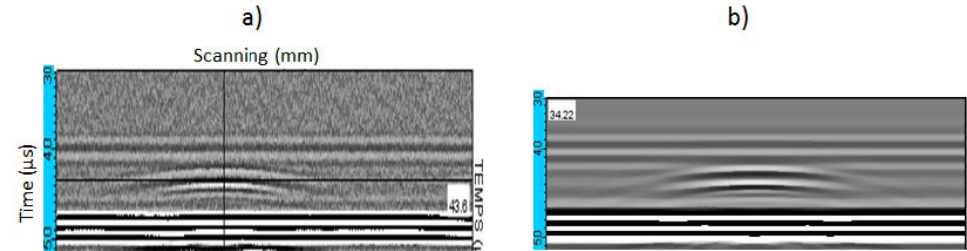
Figure 15. For the TOFD P45° waves inspection at 1 MHz: ( a ) experimental Bscan; ( b ) Bscan simulated using the 3D hybrid FEM model in simulation.